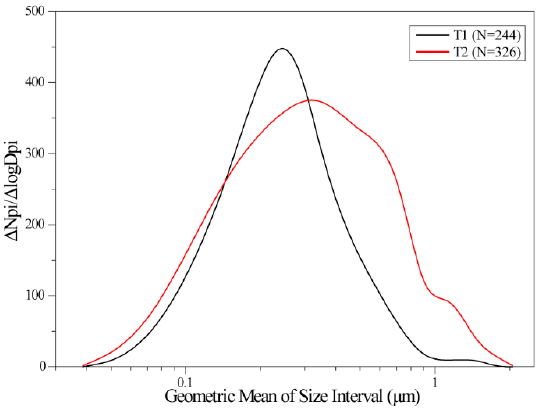
Figure 6. Size distributions of S-rich particles at the T1 site and T2 site.